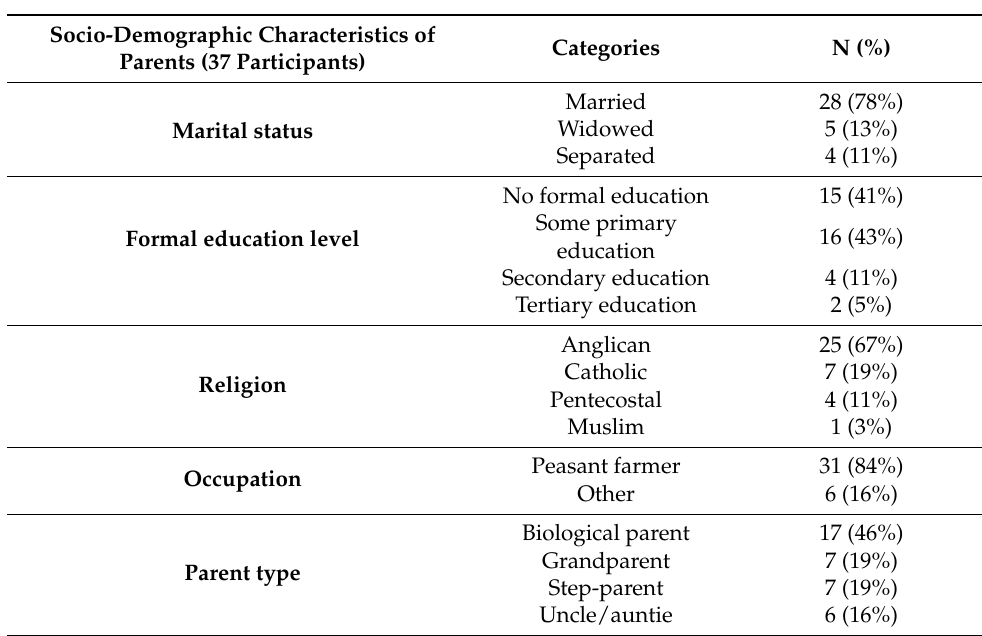
Table 1. Cont. Socio-Demographic Characteristics